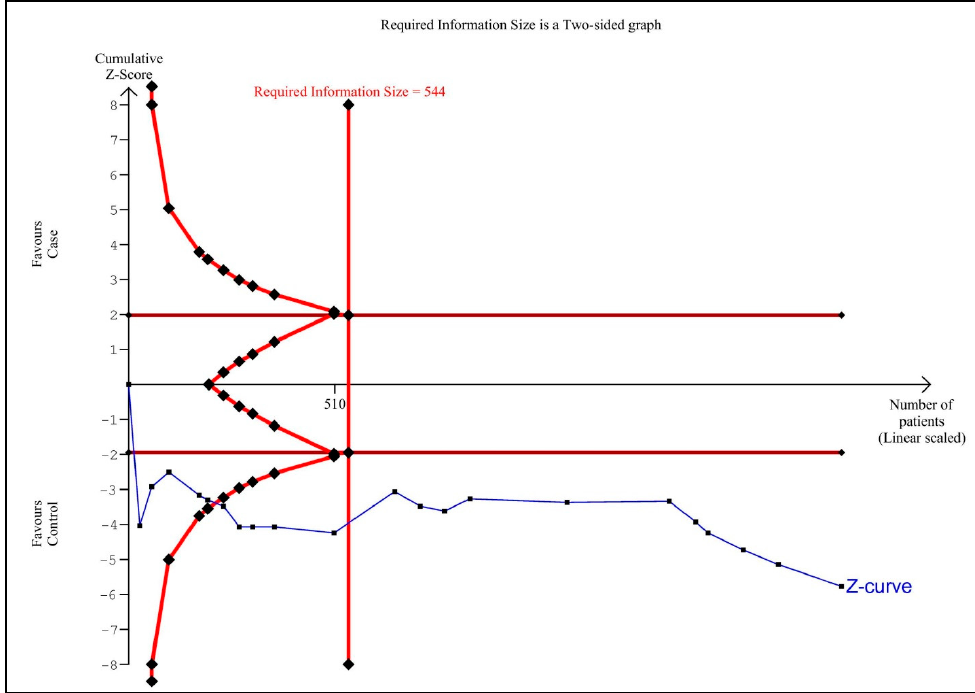
Figure 2. Trial Sequential analysis. Serum/plasma intercellular adhesion molecule-1 levels in adults with obstructive sleep apnea compared to controls.